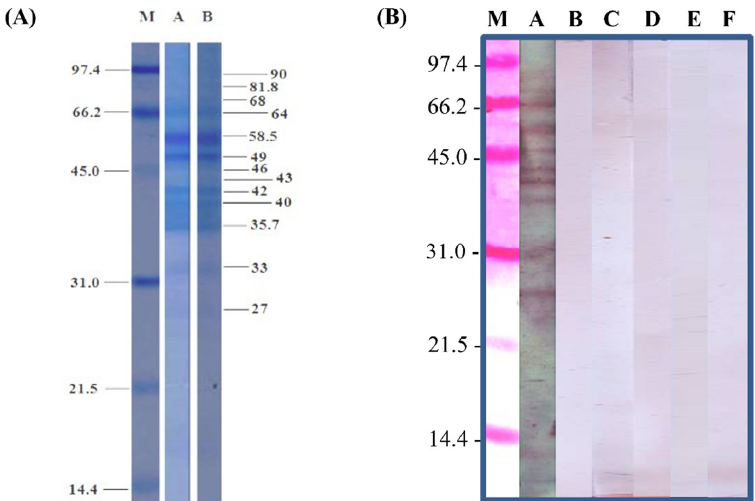
Figure 5. ( A ) Protein profile comparison of A. caninum crude extracts at 15 (A) and 30 (B) µg/well shown by Coomassie brilliant blue staining. M: low molecular weight markers (kDa). Demonstra- tion of strong bands at 58.5 and 49 kDa and faint bands from 90 to 27 kDa. ( B ) Anti-human immu-